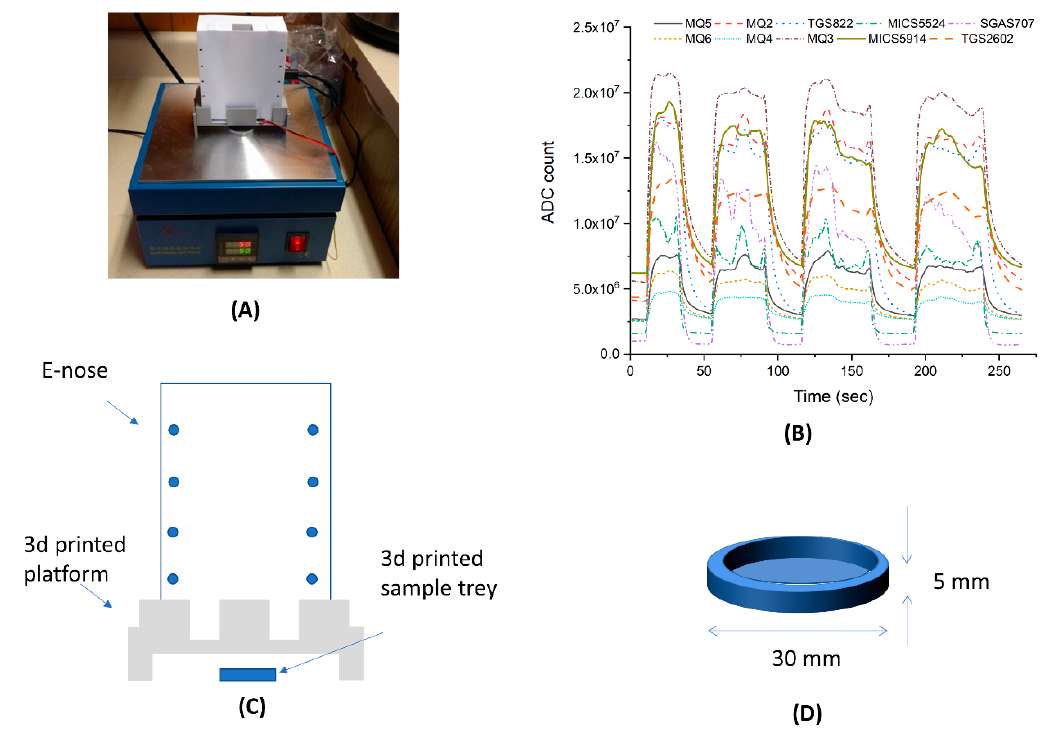
Figure 6. Experimental setup. ( A ) The actual setup. A heater set to 50 deg Celsius was used to control the volatility of the oil sample. ( B ) The response dynamics of the sensor for wine samples; different sensors show variations in time constants when samples were positioned in and out of the EMLA. ( C ) Schematics of the setup where sample tray, platform, enclosure for the EMLA were 3D-printed. ( D ) Actual dimensions of the disposable 3D-printed sample tray: a circle 30 mm in diameter with a 5 mm rim, printed with polylactic acid (PLA) filament.